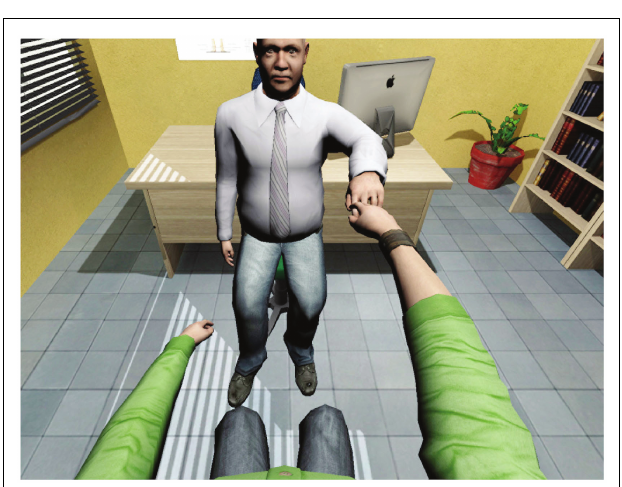
FIGURE 4 |The ring task. A virtual ring is passed along a virtual wire without touching it.Whenever the wire is touched force-feedback is enabled. Camera view is from patient’s point of view (first-person